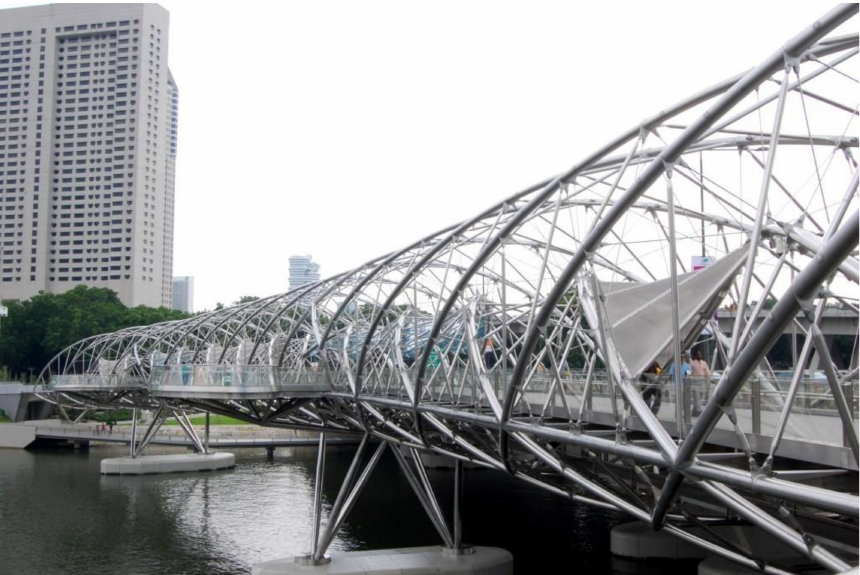
Figure 19. Marina Bay Bridge in Singapore constructed entirely of 2205 duplex stainless steel. Photo courtesy of Outokumpu Stainless